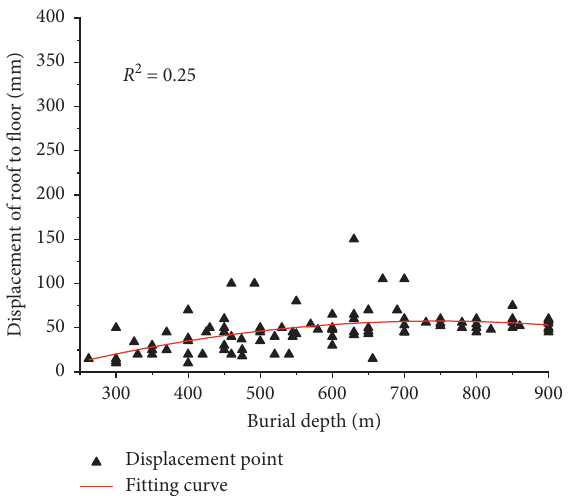
Figure 3: Displacement of roof to floor (25 th day).